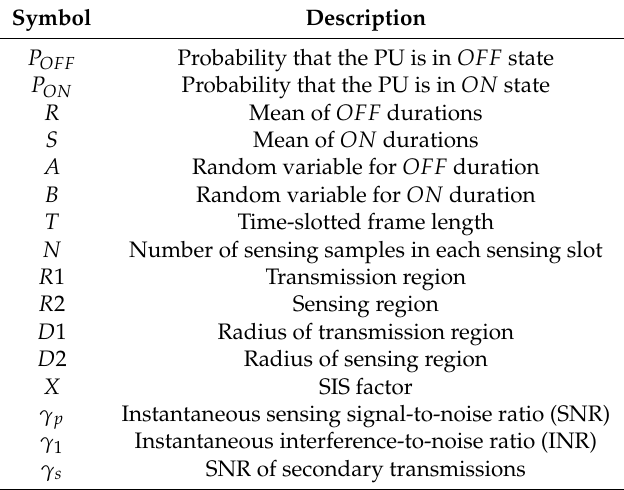
Table 1. Summary of adopted